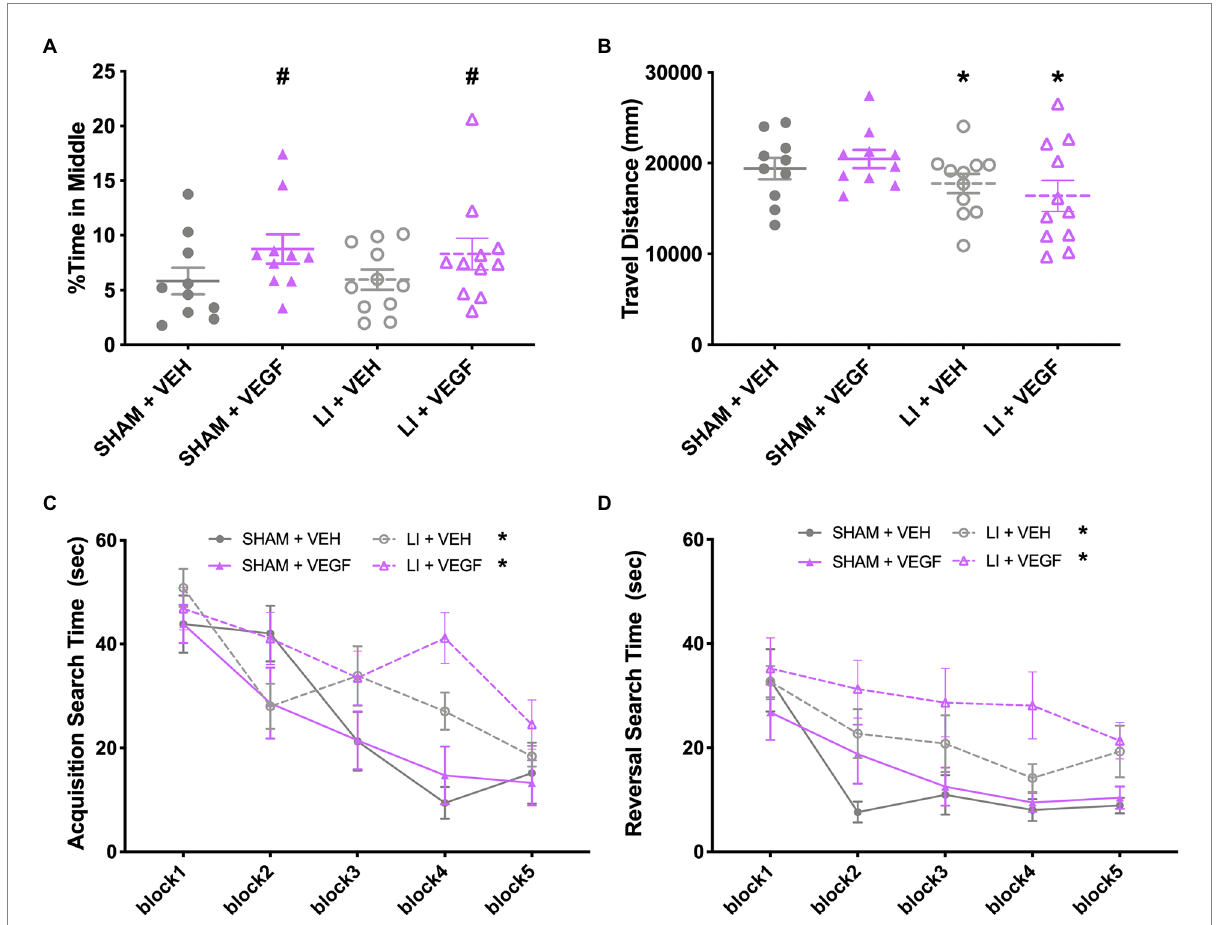
FIGURE 3 Behavior findings in female rats. In the open field, female rats treated with VEGF spent more time in the middle than VEH rats (A) , and female LI rats travelled less distance compared to shams (B) . (C) During water maze acquisition, LI rats took longer than the shams to find the platform on trials 6–8. (D) During water maze reversal, VEGF rats took longer to find the platform on trials 4 and 8 than VEH rats, and LI rats took longer to find the platform than sham rats. *, LI rats significantly different than sham rats; #, VEGF treated rats significantly different than VEH treated rats; p < 0.05. Sham+VEH, n = 10; Sham+VEGF, n = 10; LI + VEH, n = 11; LI + VEGF, n = 11. Error bar = SEM; water maze block = mean of every two